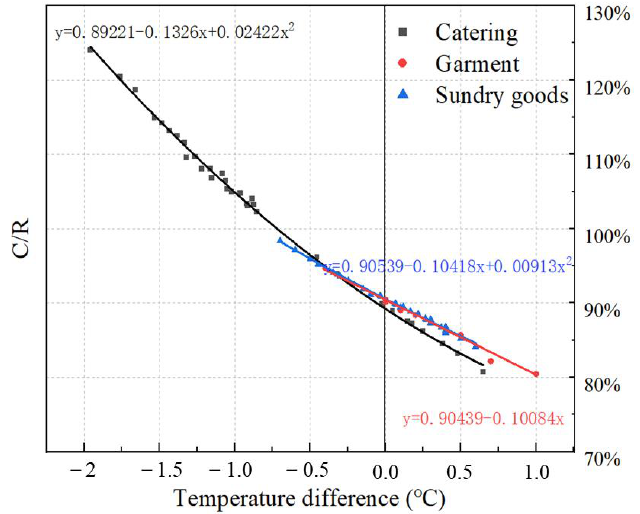
shown in Figure 15.